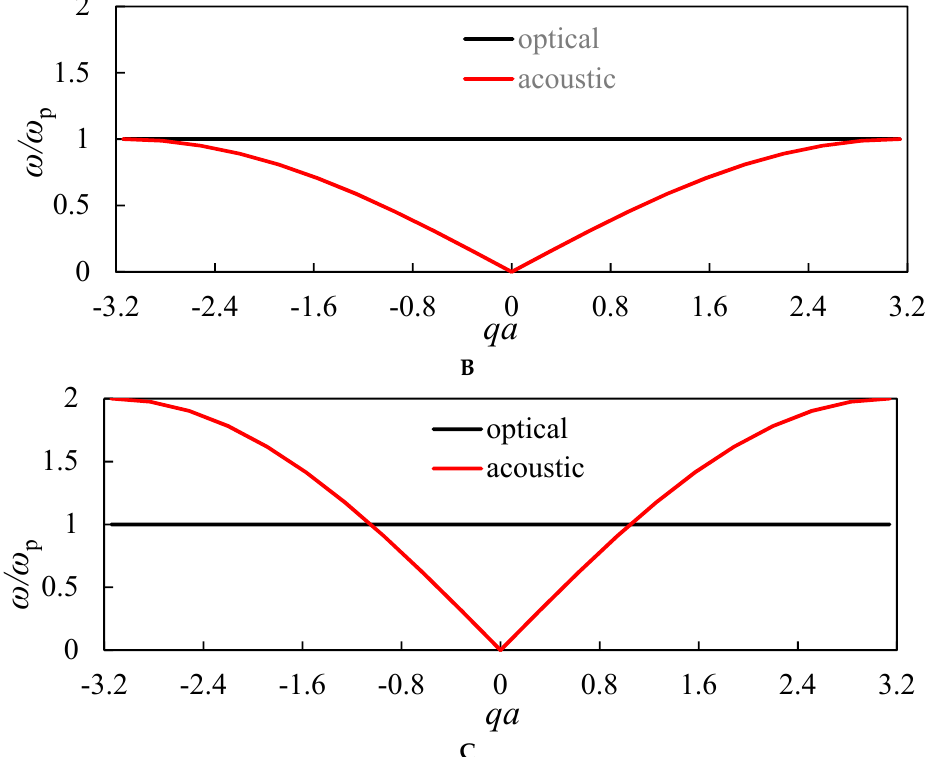
ω 1 ω . . ( A ) p (cid:3104) (cid:3291)